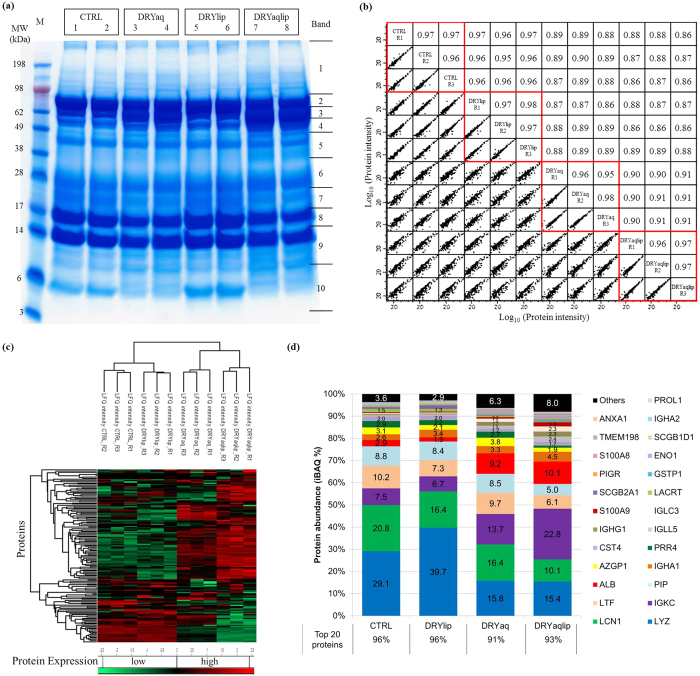
Discovery proteomics analysis via1DE & LC-ESI-MS/MS strategy reveals the characteristics of the tear proteome of DES patients.(a) Representative tear protein profiles of the DES subgroups and CTRL resolved in 1DE gel after colloidal blue staining. (b) The degree of variances in the proteome between the DES subgroups and CTRL investigated by Pearson correlation analysis. (c) The heat map shows hierarchical clustering analysis of the 200 tear proteins that separates the designated groups into two main clusters. (d) The bar chart shows the degree of protein abundance in DES subgroups and CTRL.